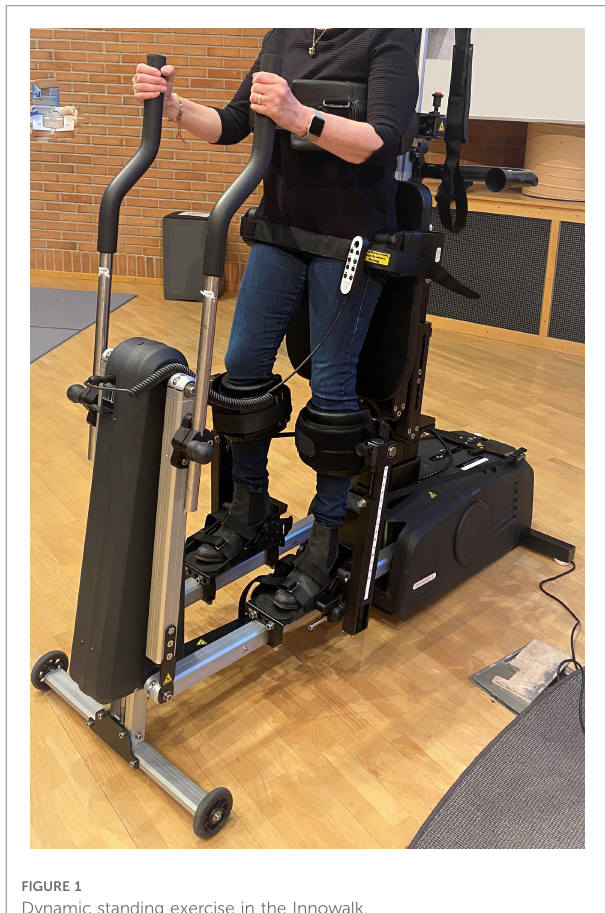
FIGURE 1 Dynamic standing exercise in the